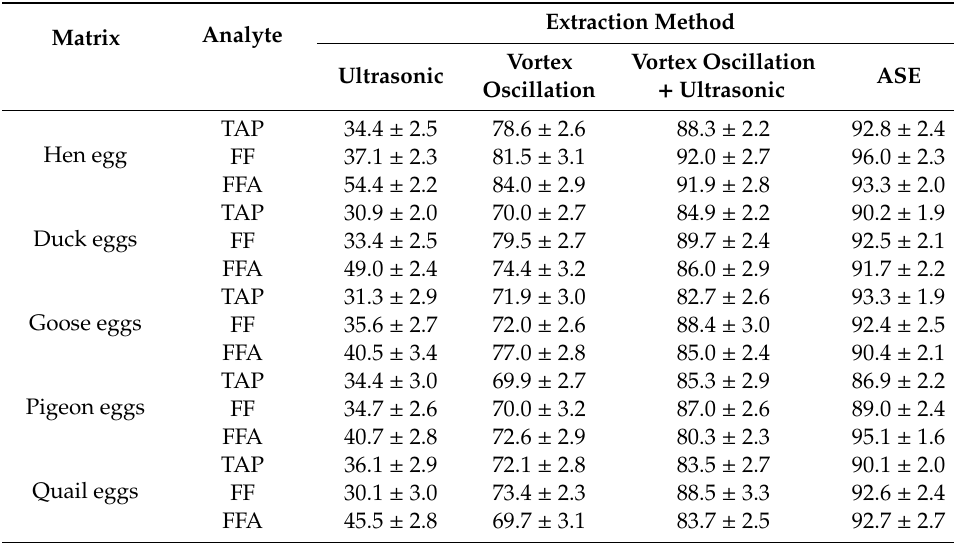
Table 2. E ff ects of di ff erent extraction methods on the recoveries of 25 µ g / kg TAP and 50 µ g / kg FF and FFA from poultry eggs (%) ( n =